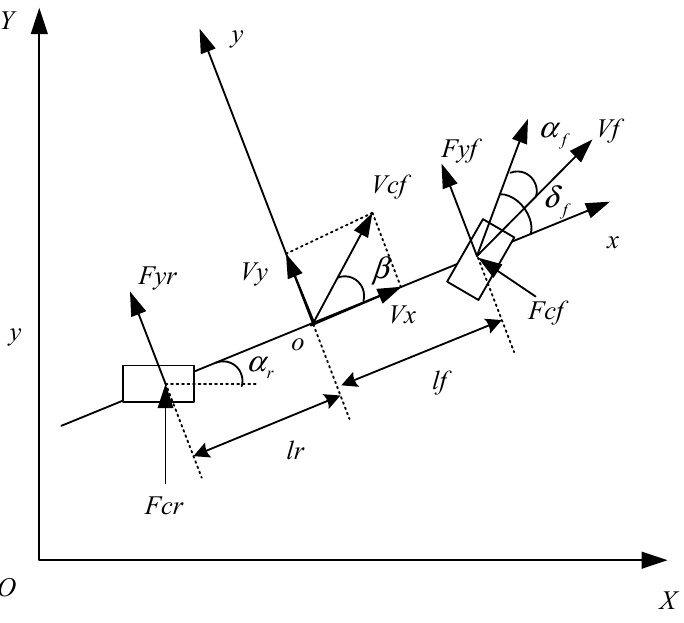
Figure 1. The SUGV